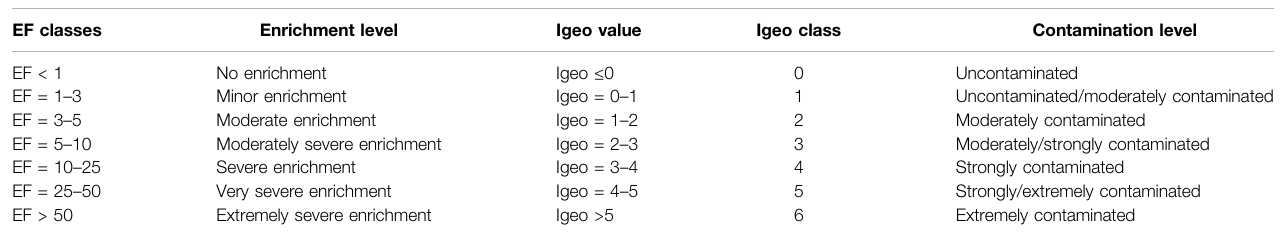
TABLE 2 | Classi fi cation standard of enrichment factor (EF) and geoaccumulation index (Igeo). EF classes